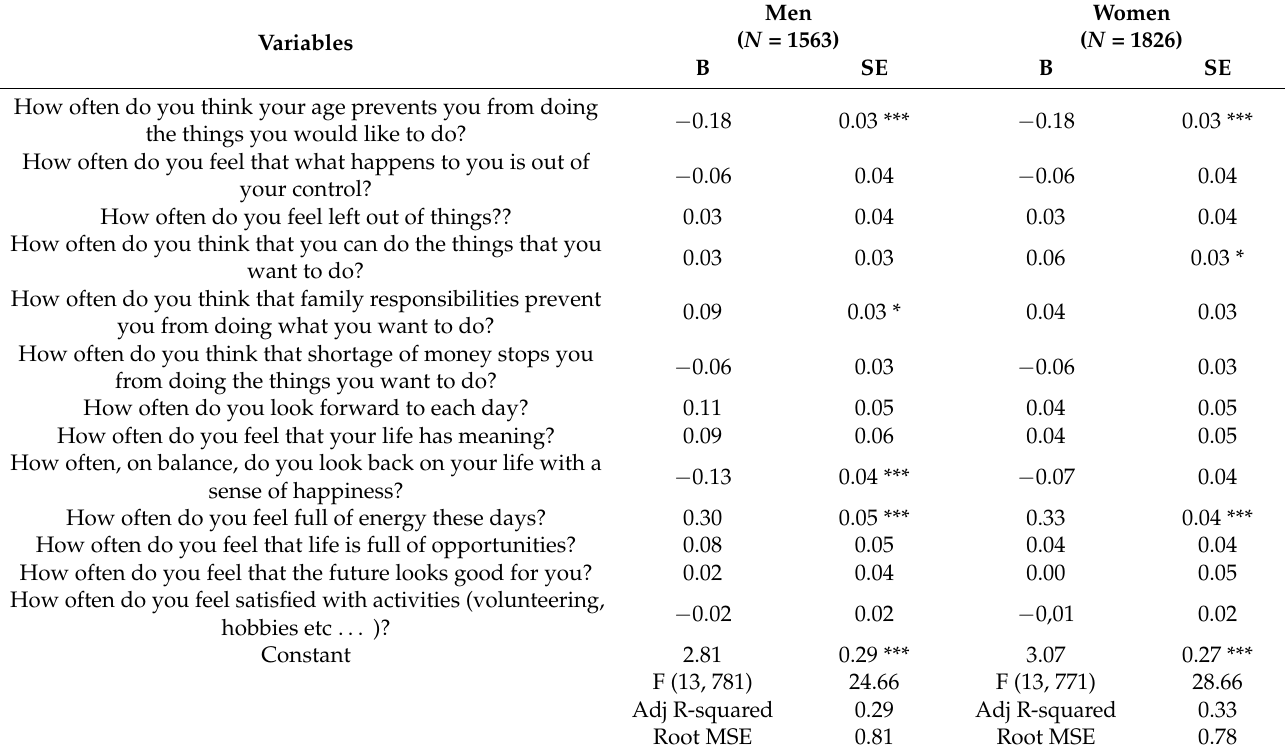
Table 3. Linear standardized regression models of perceived health status by gender using SHARE data. Standardized β